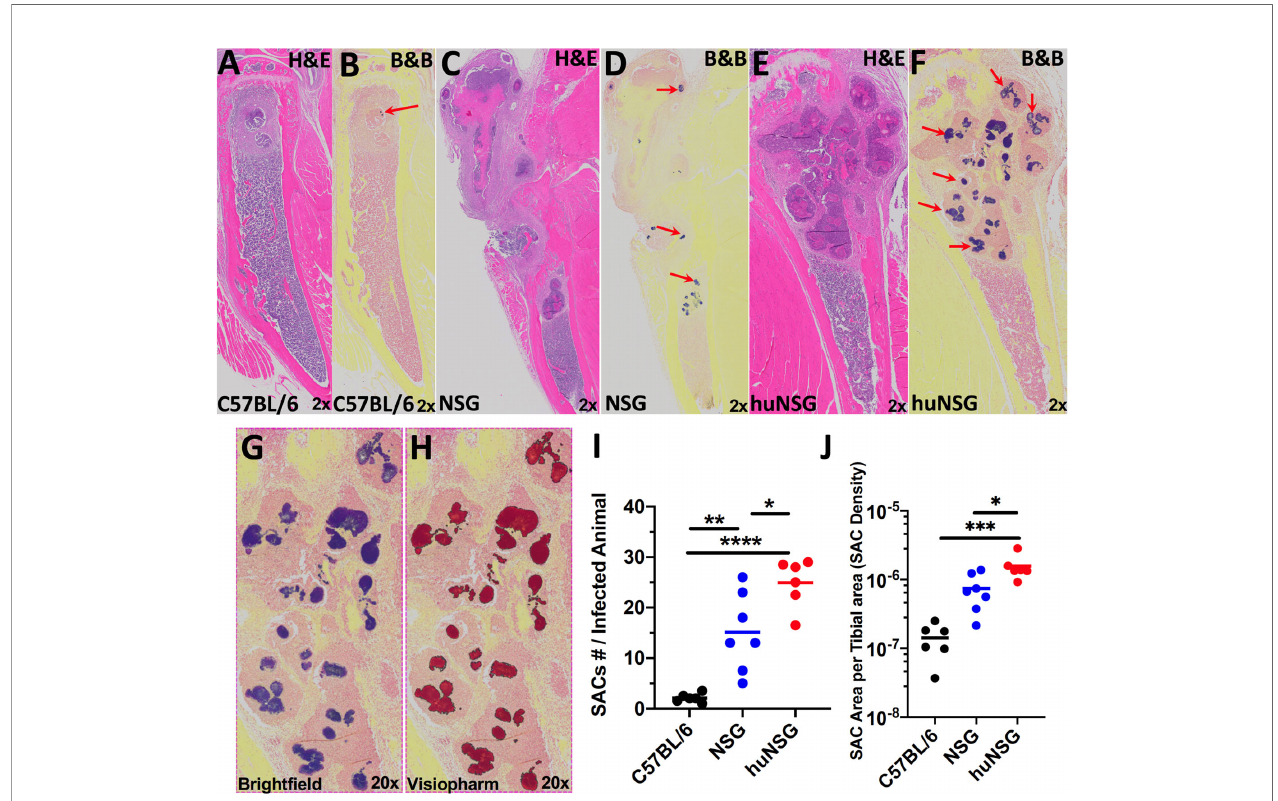
FIGURE 4 | Humanized mice exhibit increased Staphylococcal abscess community (SAC) formation. WT, NSG, and huNSG mice received MRSA infected transtibial implants, and the tibiae were harvested on day 14 post-op for histology and assessment of SACs. Representative micrographs of H&E (A, C, E) and Brown & Brenn Gram (B, D, F) stained sections are presented to illustrate the abscesses and Gram-positive bacteria (red arrows). (G, H) Digital scans of the histology were processed by Visiopharm software, which recognized the Gram-stained bacteria, and scored the positive pixels (purple to red color conversion) for automated histomorphometry of SAC numbers per tibia (I) and SAC area per tibia (J) . The data are presented for each mouse with the mean for each Group (n = 6-7, * p < 0.05, ** p < 0.01, *** p < 0.001 one-way ANOVA).